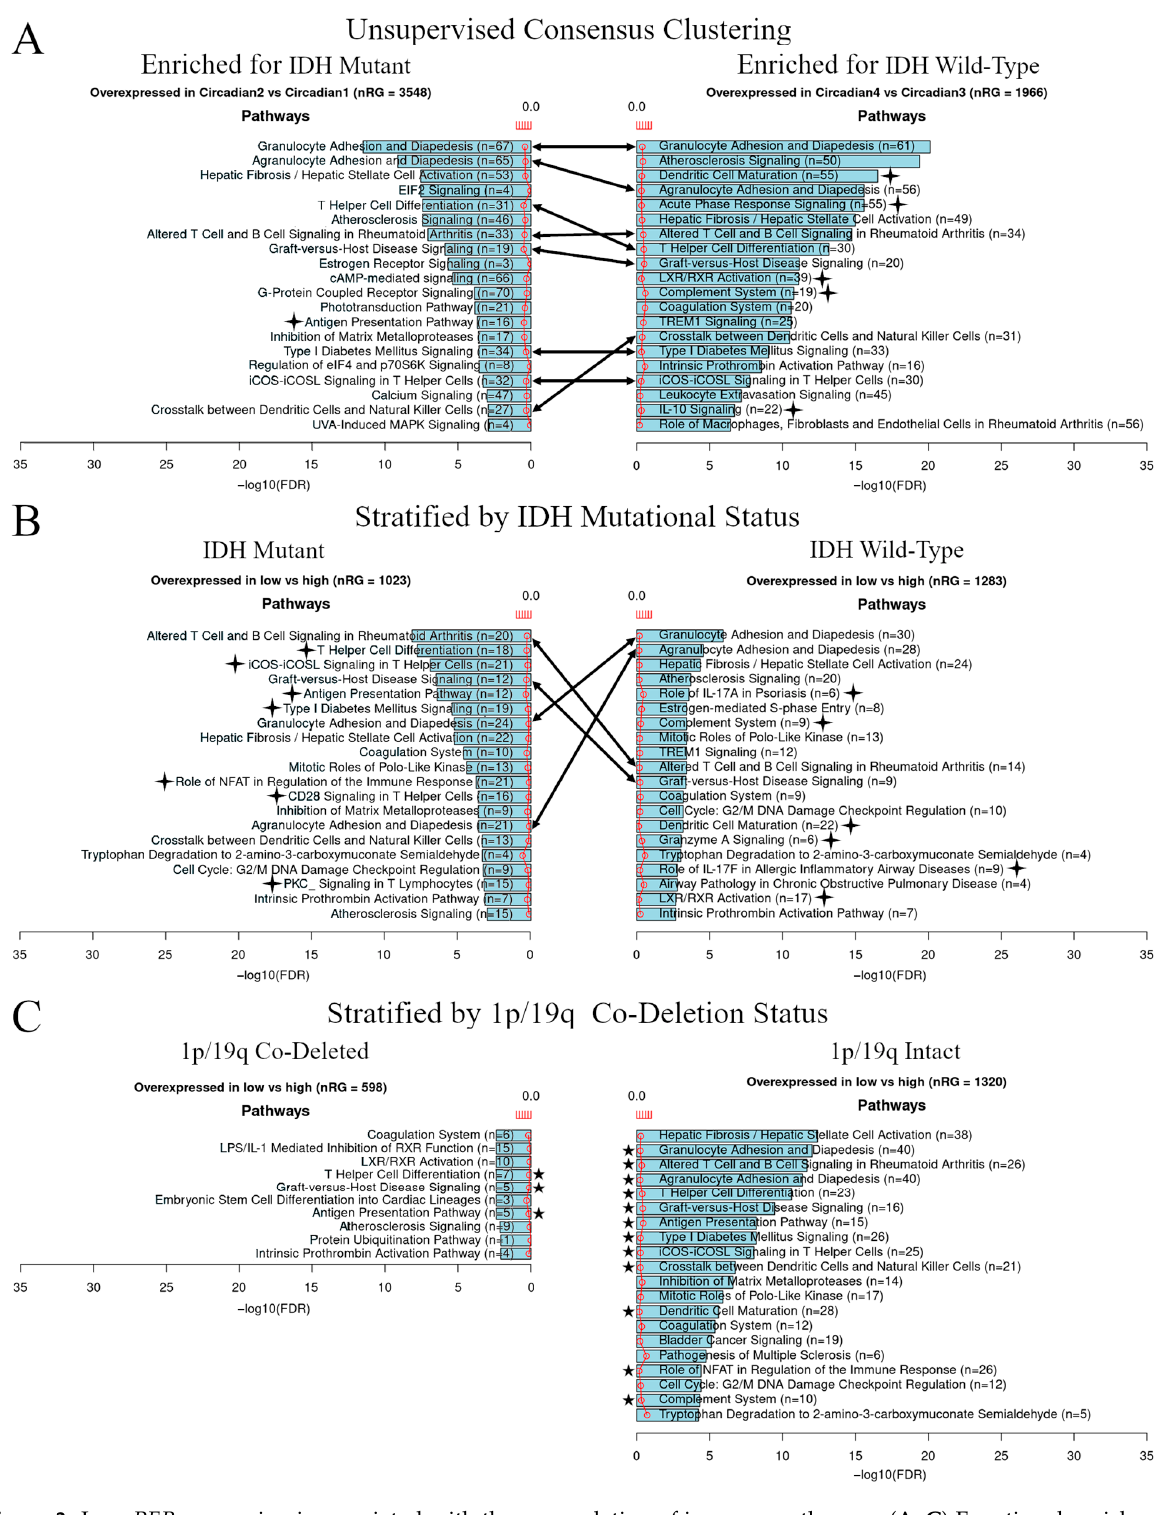
Figure 3. Low PER expression is associated with the upregulation of immune pathways. ( A – C ) Functional enrichment analysis showing overexpressed pathways in low PER versus high PER enriched for IDH -mutated and IDH wild-type clusters ( A ). Analysis showing overexpressed pathways in low versus high PER expression stratified by the median PER expression levels in samples stratified by IDH mutation ( B ) and 1p/19q co-deletion status ( C ). Lines with arrows show immune pathways commonly overexpressed across groups. Stars represent the immune pathways overexpressed uniquely in a group. The red line shows the ratio of list genes found in each pathway over the total number of genes in that pathway.